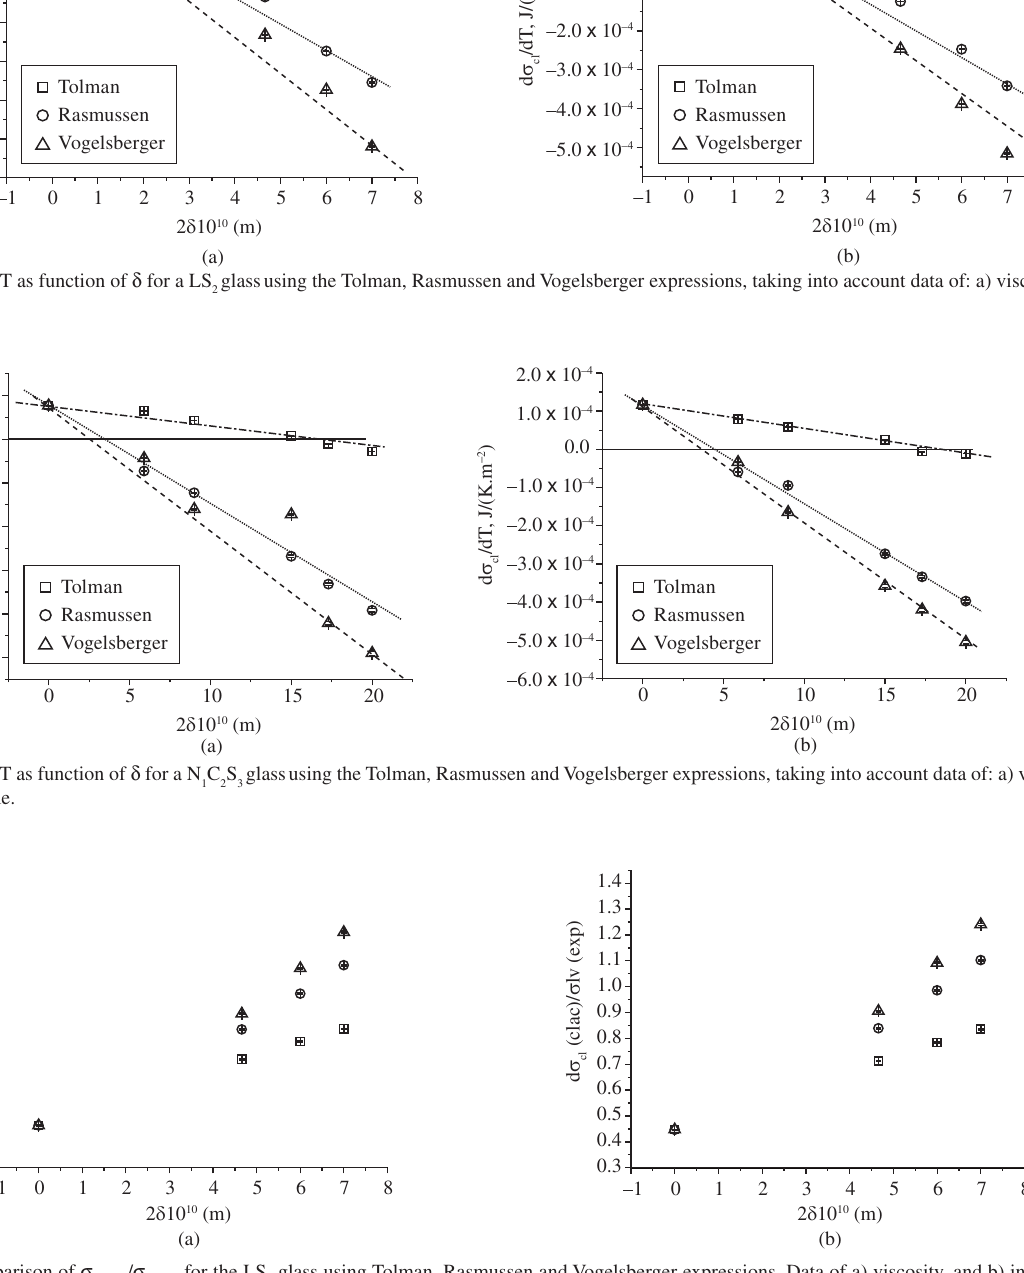
/ σ for the LS glass using Tolman, Rasmussen and Vogelsberger expressions. Data of a) viscosity, and b) induction time cl(calc) lv(exp) 2